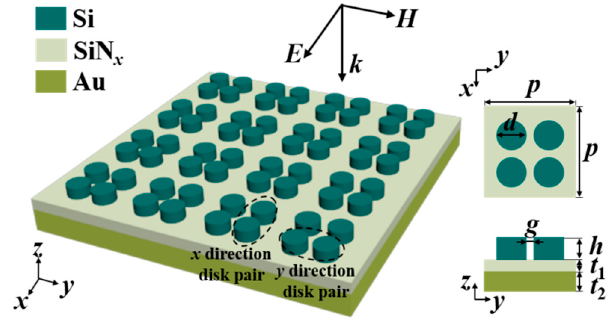
Figure 1. Schematic view of the MPA and its unit